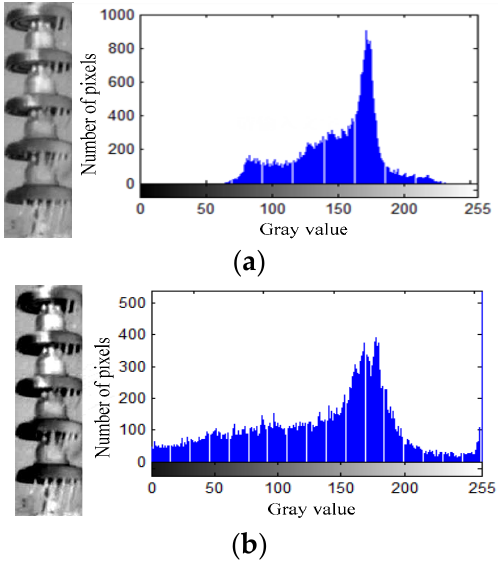
Figure 2. Color image and grayscale image. (2.) Gray Stretch